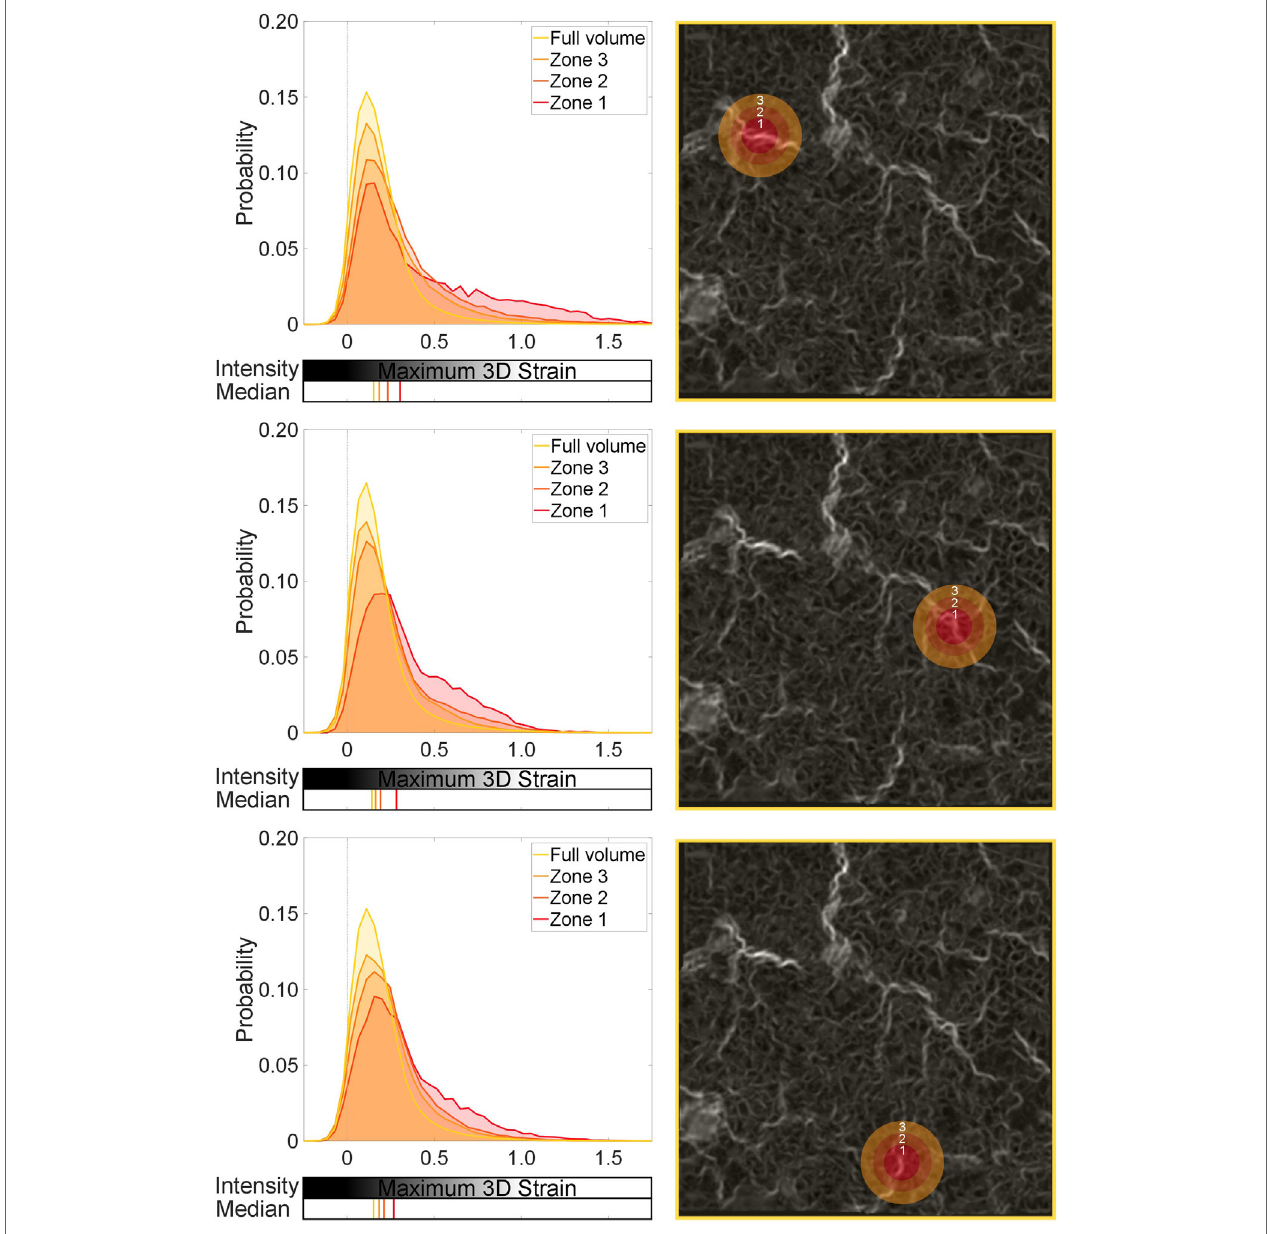
FigUre 8 | Global and local strain distributions around a strain concentration: low-level blast. Three regions are selected, with sequential spherical shell volumes analyzed to show the effect of the local strain discontinuity on the surrounding tissue. Zone 1 is the central sphere focused on a given strain concentration. Zones 2 and 3 are shells leading from Zone 1. The median for each distribution is also